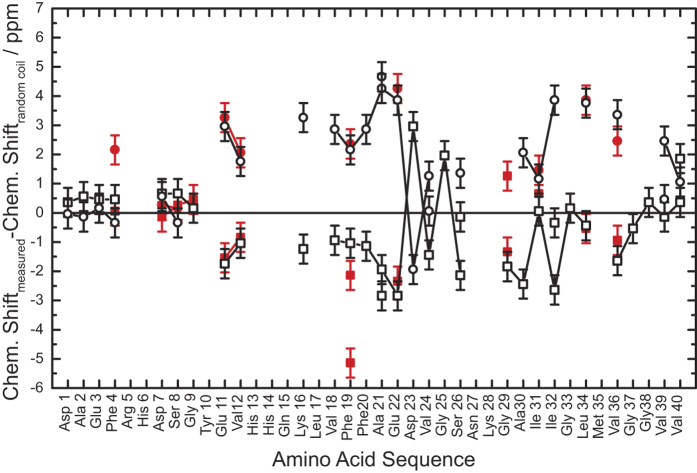
Comparison of the secondary 13C MAS NMR chemical shifts of pGlu3-Aβ(3–40) (red) and mature WT Aβ(1–40) (black) fibrils for 13Cα (squares) and 13Cβ (circles).Data are given as the difference of a measured chemical shift to random coil chemical shifts taken from the literature22.